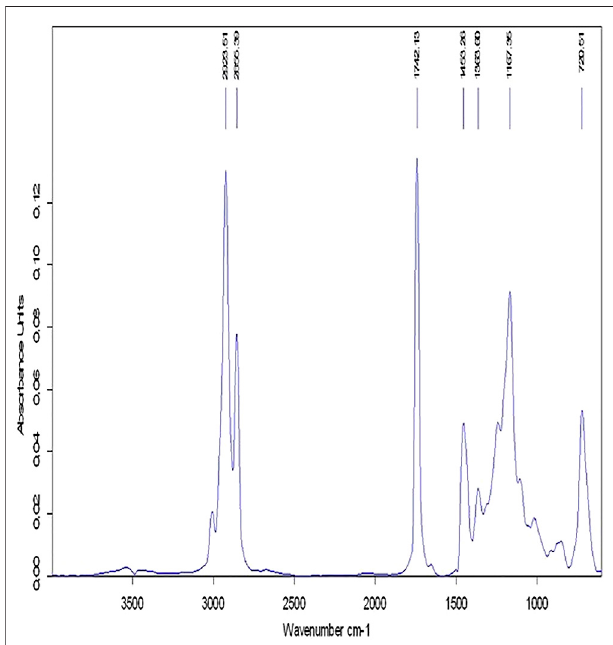
FIGURE 8 | FT-IR spectrum showing various peaks in the Dodonaea prepared